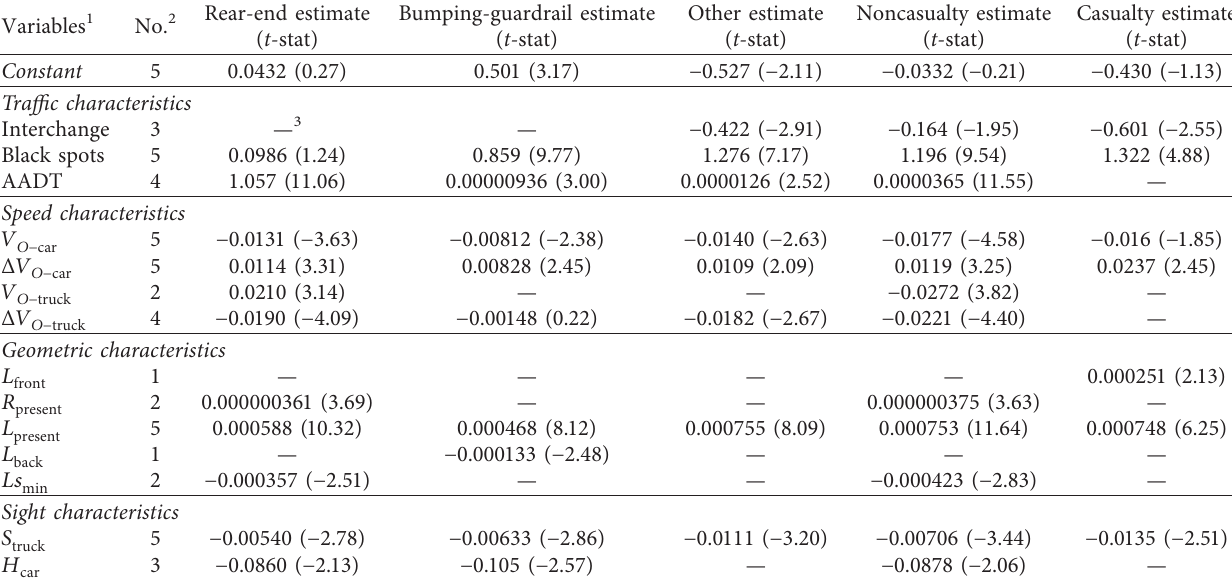
Table 3: Random-parameter multivariate Poisson model estimation results.